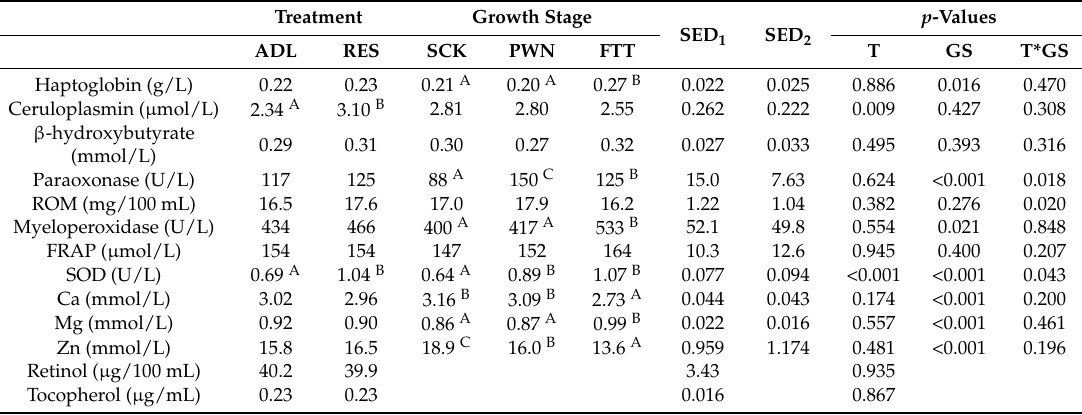
Table 1. Biochemical parameters of fattening lambs fed ad libitum (ADL) or restricted (RES) diets during the suckling